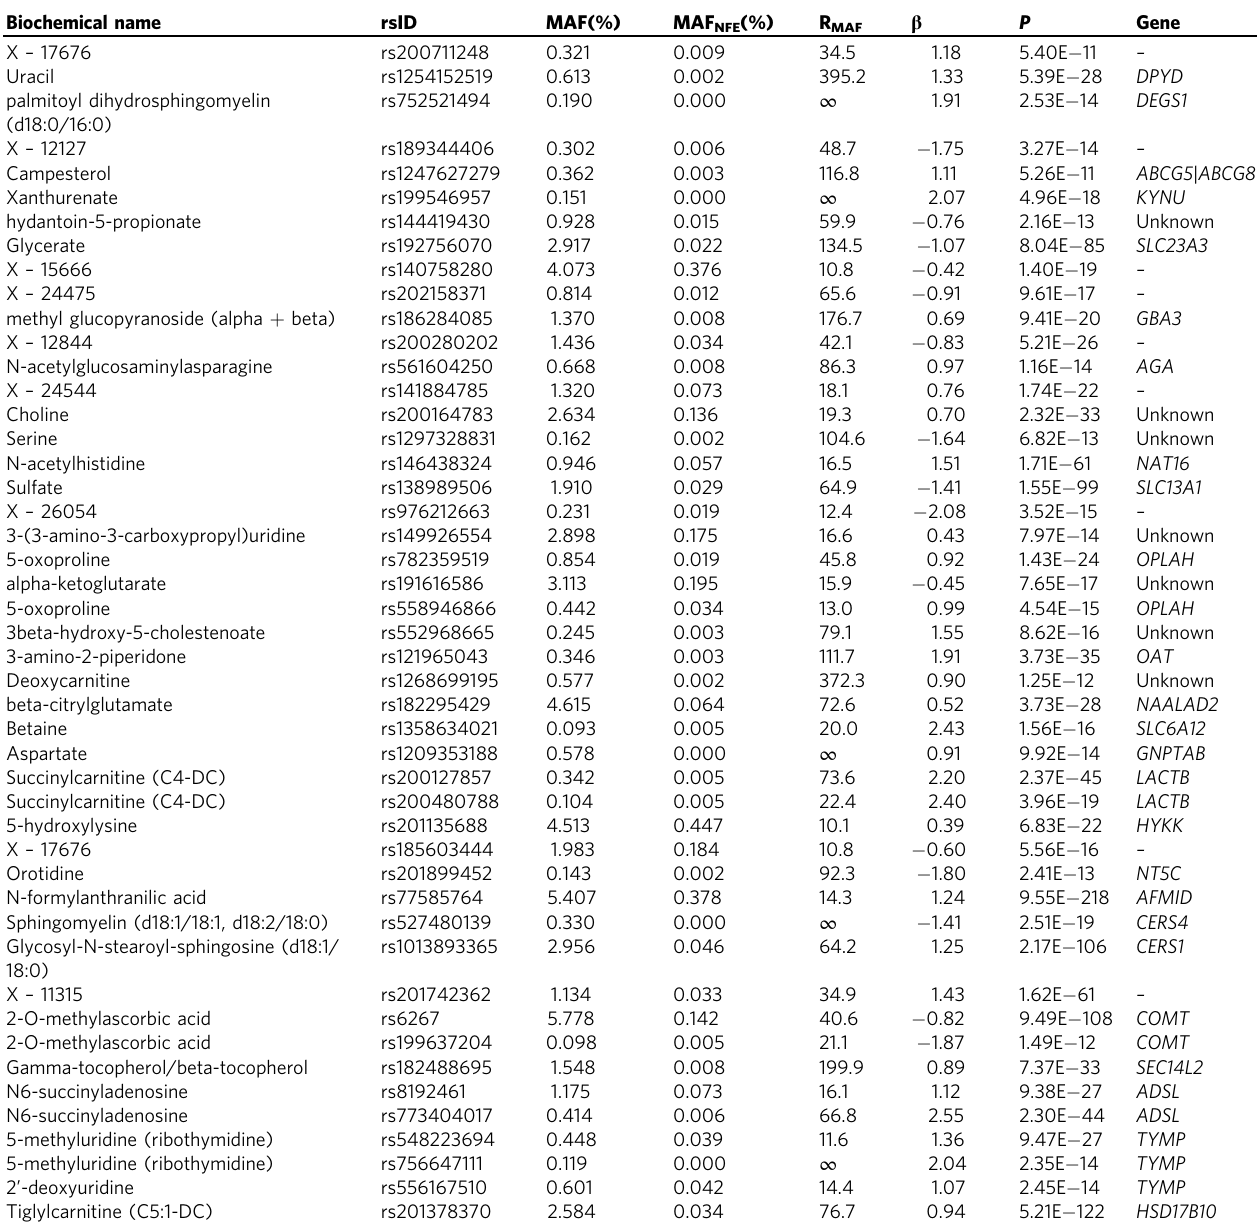
Table 2 Top metabolite genetic association signals at 47 novel variants with MAF>10-fold greater in METSIM than in gnomAD v3.1 non-Finnish